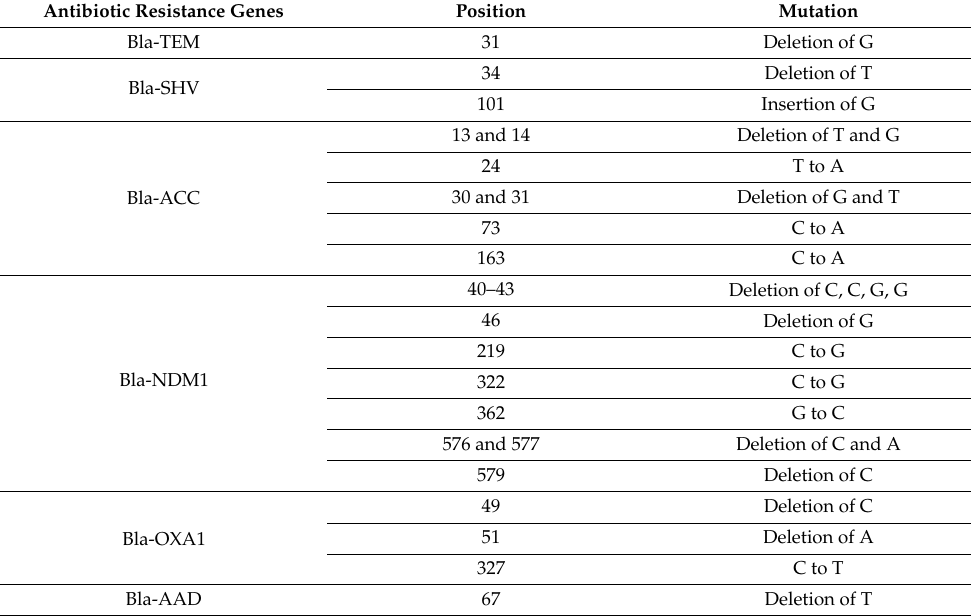
Table 7. Mutations detected in the selected antibiotic-resistant genes.